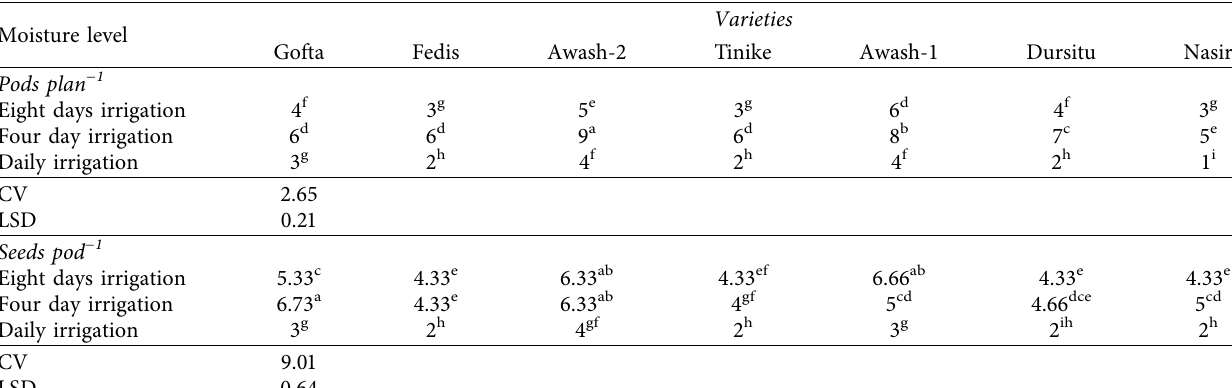
Table 9: Interaction efects of common bean varieties and irrigation interval on pods plant − 1 and seeds pod − 1 under lath house from June to